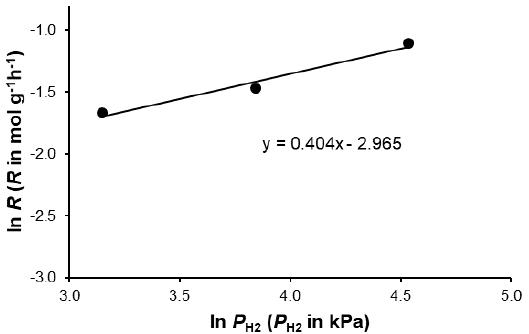
Figure 5. Effect of hydrogen partial pressure on the rate of DMF hydroconversion over 9.6%Pt/C + SiO 2 catalyst (0.20 g total weight, 2.5 mg Pt/C) at 6.8 kPa DMF partial pressure, 70 °C, 40 ml·min −1 H 2 + N 2 flow rate with varied H 2 /N 2 ratio.